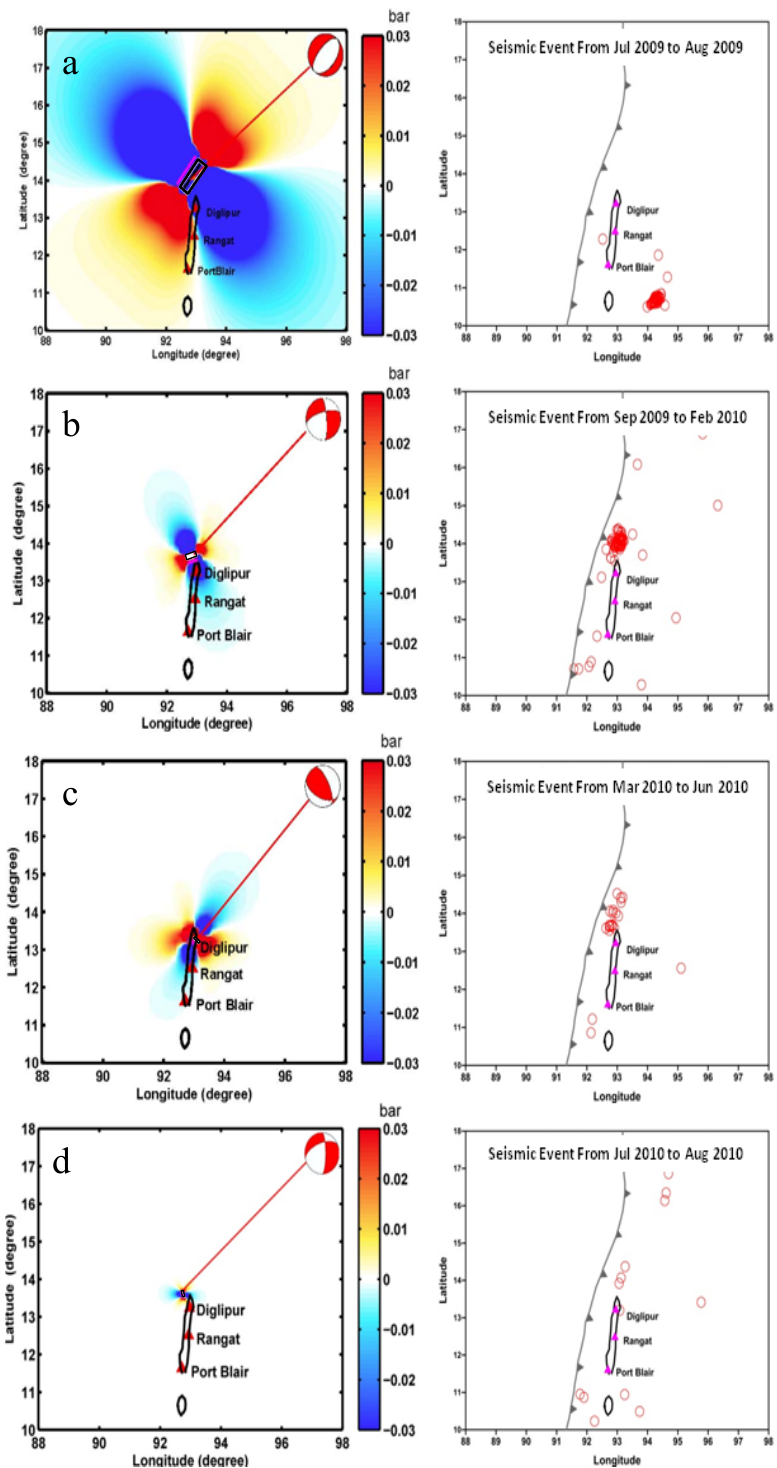
Fig. 4. The left side panels give Coulomb stress change for the four Diglipur earthquakes that occurred on (a) 10 August 2009, (b) 30 March 2010, (c) 18 June 2010 and (d) 9 August 2010 indicated by stars. The fault parameters are shown in Table 3. Beach ball symbols indicate fault plane solutions for each of those earthquakes. The corresponding right side panels show the distribution of aftershocks illustrated by red circles; the black line indicates the subduction zone boundary.